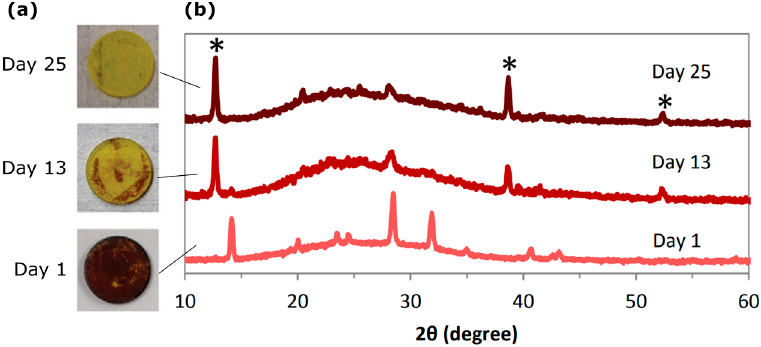
Figure 3. Degradation of MAPbI 3 . ( a ) Photographs of MAPbI 3 degradation and ( b ) corresponding X-ray di ff raction (XRD) spectra of the same samples after 1, 13, and 26 days stored in ambient conditions. The starred peaks in the XRD spectra correspond to PbI 2 . Reproduced from ref. [30], with permission from John Wiley and Sons, 2016.